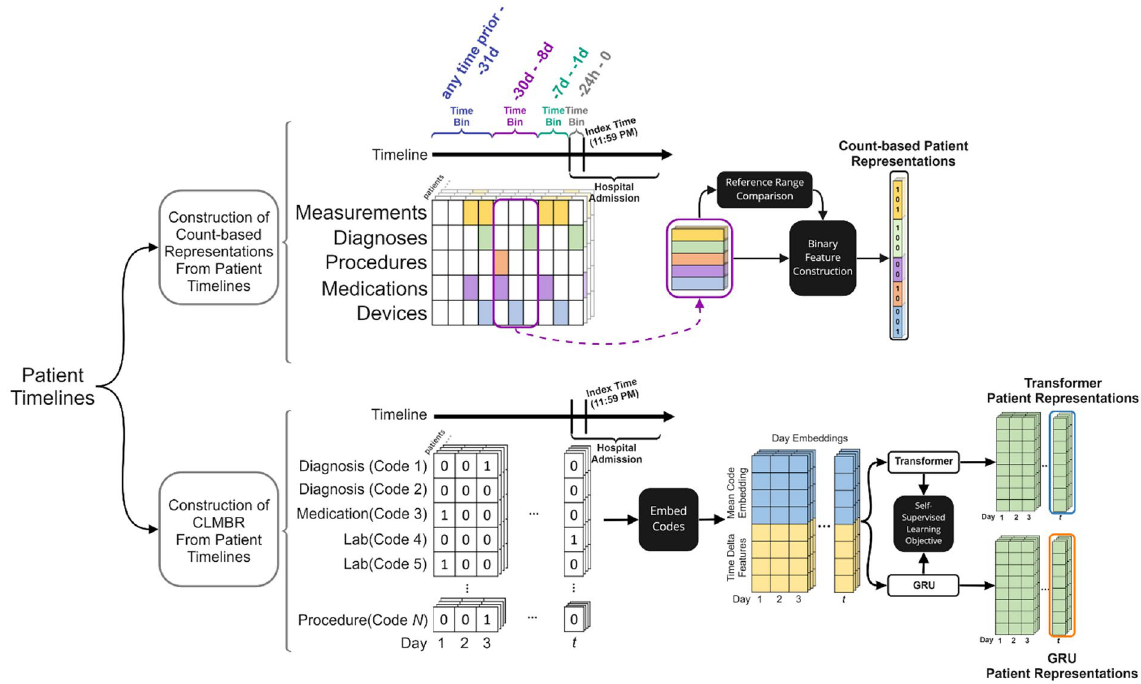
Figure 1. An overview of the two approaches of constructing patient representations used in this study. The purple box in the construction of count-based representations represents the reference range comparison and binary feature construction procedures for a specific time-bin. The construction of CLMBR illustrates the self- supervised pretraining stage, hence the inclusion of the self-supervised learning objective. The adaptation of CLMBR to specific tasks (e.g., for predicting hospital mortality) does not include the self-supervised learning objective. In addition, during adaptation CLMBR weights were frozen, and a separate classification head is learned on the same patient representations for each clinical prediction task. CLMBR Clinical language model- based